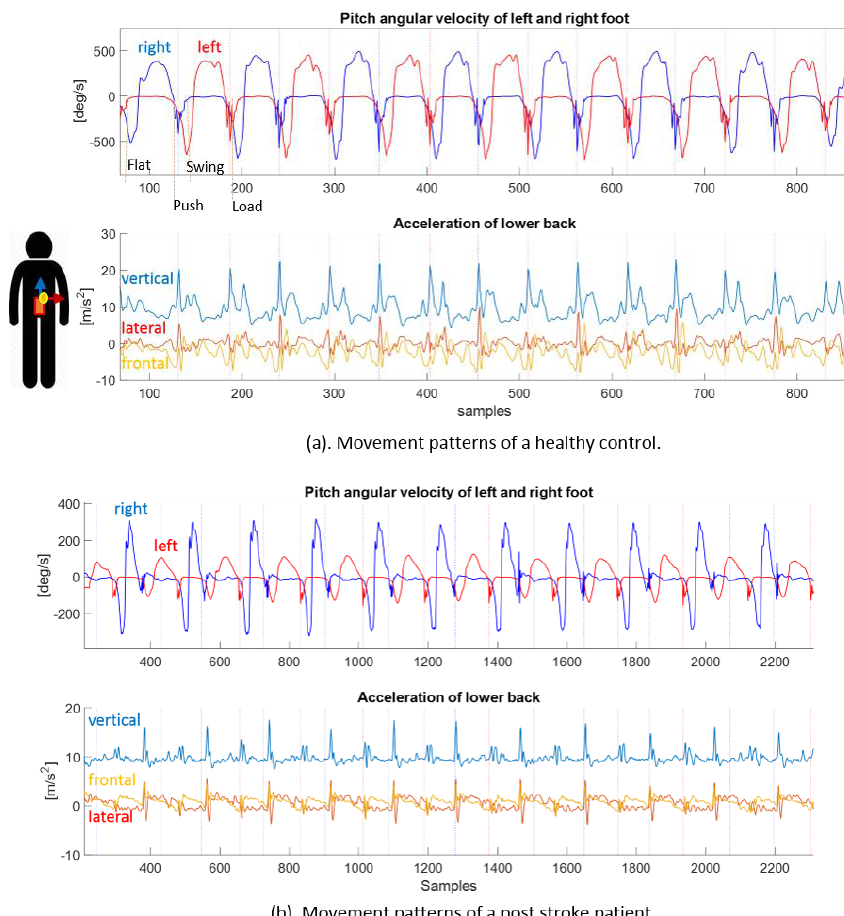
Figure 1. Synchronized pitch angular velocity signals from feet sensors and 3D acceleration signals from low back sensor. ( a ) Synchronized signals from a healthy control. ( b ) Synchronized signals from a post-stroke patient. Upper plot shows foot pitch angular velocity on the left (red) and right (blue) side during walking. Lower plot shows lower back acceleration on the vertical (blue), frontal (yellow) and lateral (red) axis. The dotted vertical lines indicate of each gait cycles detected by the feet sensors. In ( a ), time phases of foot-flat, push-up, swing and loading in one cycle of the left foot are indicated in the pitch angular velocity signal. Axes of the accelerometer at the low back are illustrated next to the acceleration signals.